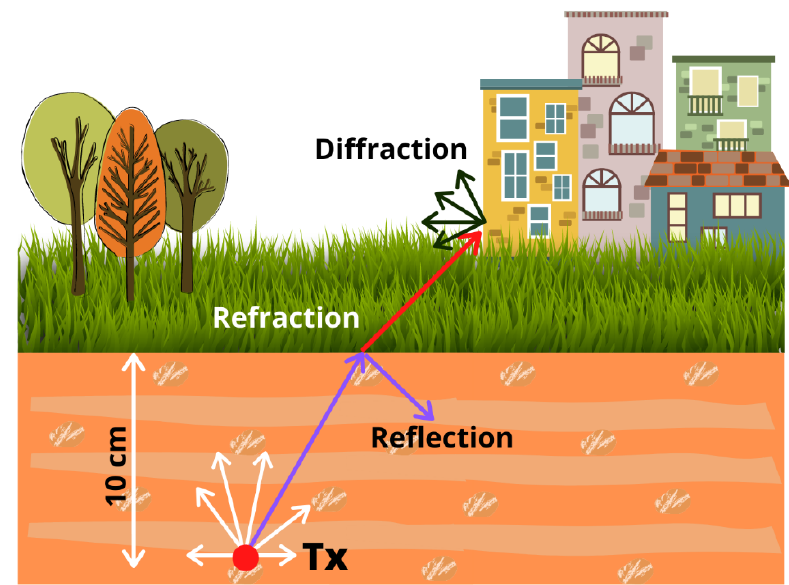
Figure 8. Operation principles and propagation phenomena of the used 3D-RL